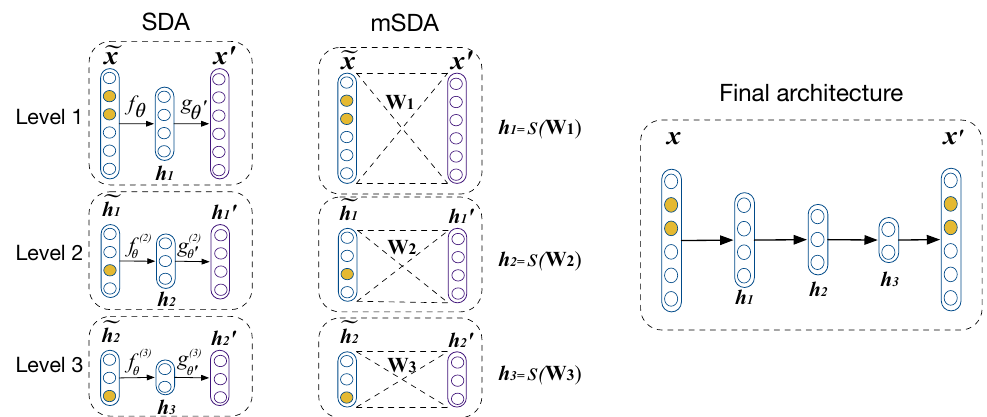
Figure 2. SDA, mSDA, and how their latent representations are used to create the final